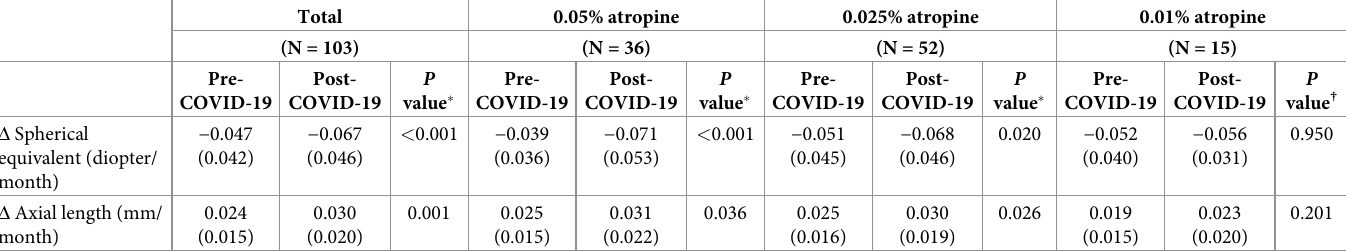
Table 2. Comparisons of the changes of refractive error and axial length between pre- and post-coronavirus disease in the 0.05% atropine, 0.025% atropine, and 0.01% atropine groups.